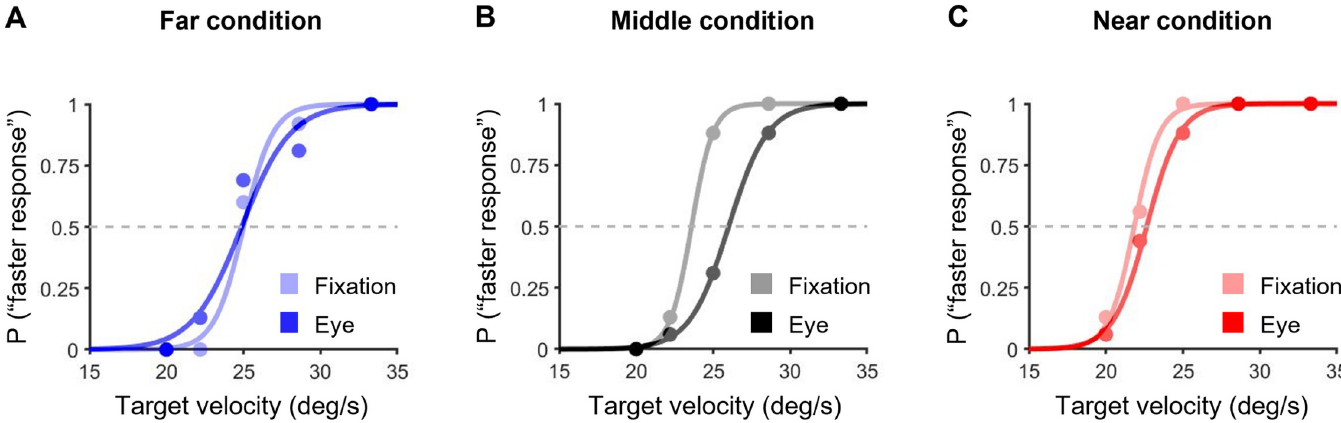
Fig 9. Comparisons of psychometric functions between the fixation and eye movements tasks in the far (A), middle (B) and near (C) conditions. The light colored and dark colored lines indicate the fixation and eye movement tasks, respectively. The blue, black and red lines indicate the far, middle and near conditions, respectively.